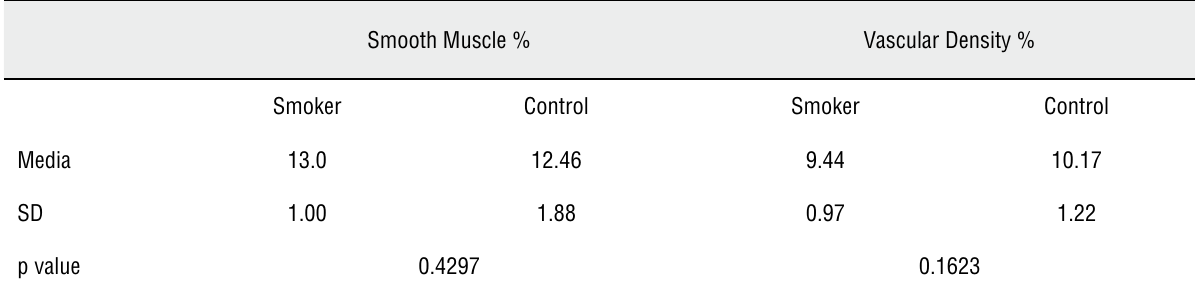
Table 1 - The table shows the results of stereological analysis of smooth muscle fibers and vascular density of the foreskin of the penis in smokers and the control group.